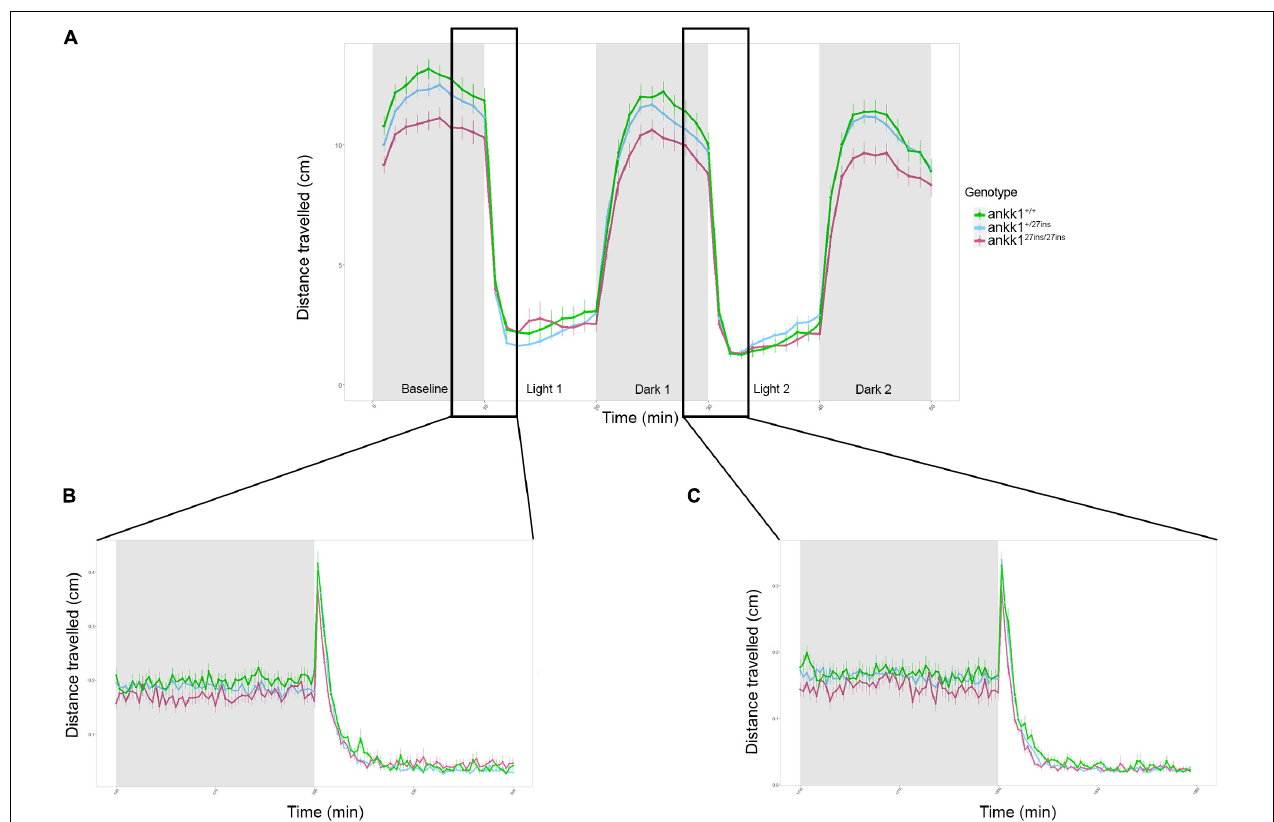
FIGURE 7 | Forced light/dark test in 5 days post fertilization zebrafish larvae ( ankk1 + / + , ankk1 + / 27 ins , ankk1 27 ins / 27 ins ). (A) The assay consisted of 10 s of basal tracking, followed by two light/dark cycles of 10 min each. Dots represent mean distance traveled per minute. Error bars show standard error of the mean. (B,C) One-second time bins resolution plots of the dark/light